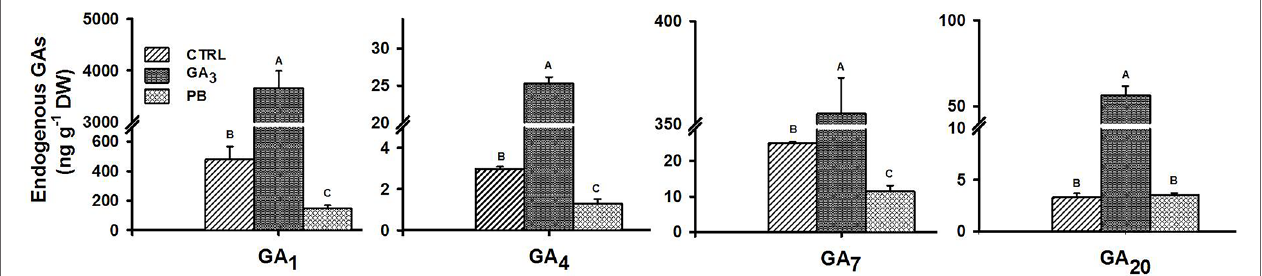
FiGURe 4 | Effect of GA 3 application on endogenous GAs levels in sweetpotato “ Georgia Jet ” roots. Levels of bioactive (GA 1 , GA 4, and GA 7 ) and inactive (GA 20 ) forms of GA, measured at two weeks (2W) after planting, are presented. Bars represent mean of three independent biological replicates (each consisting of roots pooled from four individual plants) ± SE. Significance analysis was performed by using student’s t-test ( P ≤ 0.05) , where unlike letters represent significant differences between treatments within a sampling group. CTRL, Control (treated with water); GA 3 , application of 50 ppm gibberellic acid 3 for two weeks; PB, application of 5 ppm paclobutrazol for two weeks. The content of GA 3 (active form) was relatively high, reaching values 10,000, 70,000, and 4,000 ng g -1 DW for CTRL, GA 3, and PB treatment groups,